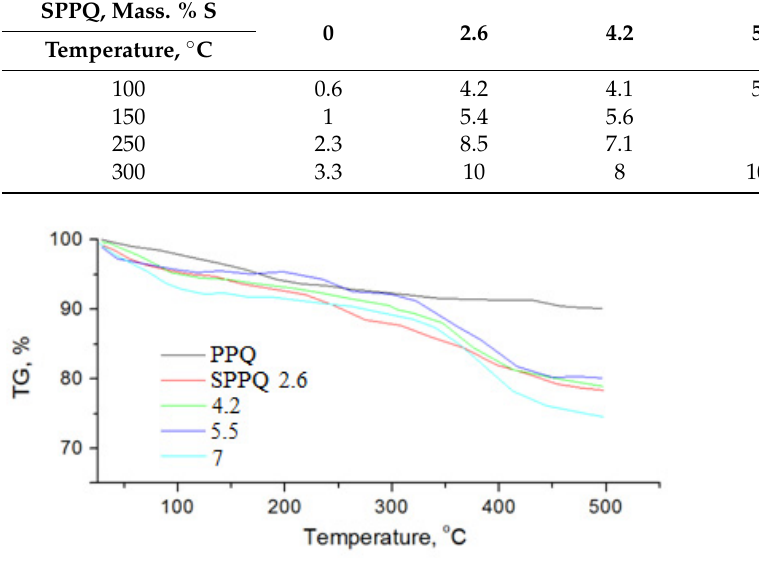
Figure 2. TGA of SPPQ samples up to 300 °C in Ar atmosphere, rate 5 °C/min.